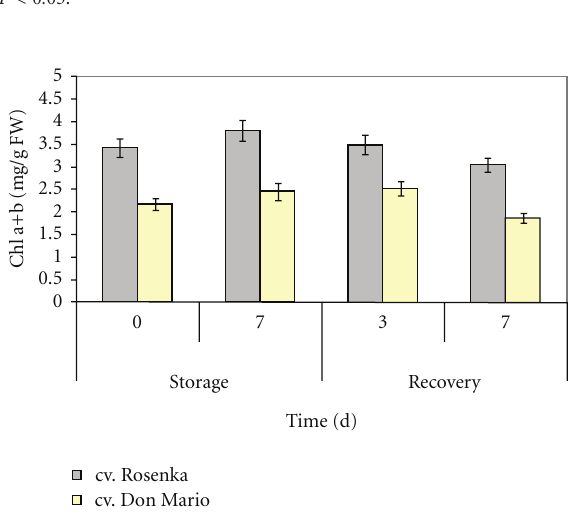
Figure 1: Total chlorophyll of flowering Bougainvillea potted plants during storage and recovery. Values are means with standard errors ( n =